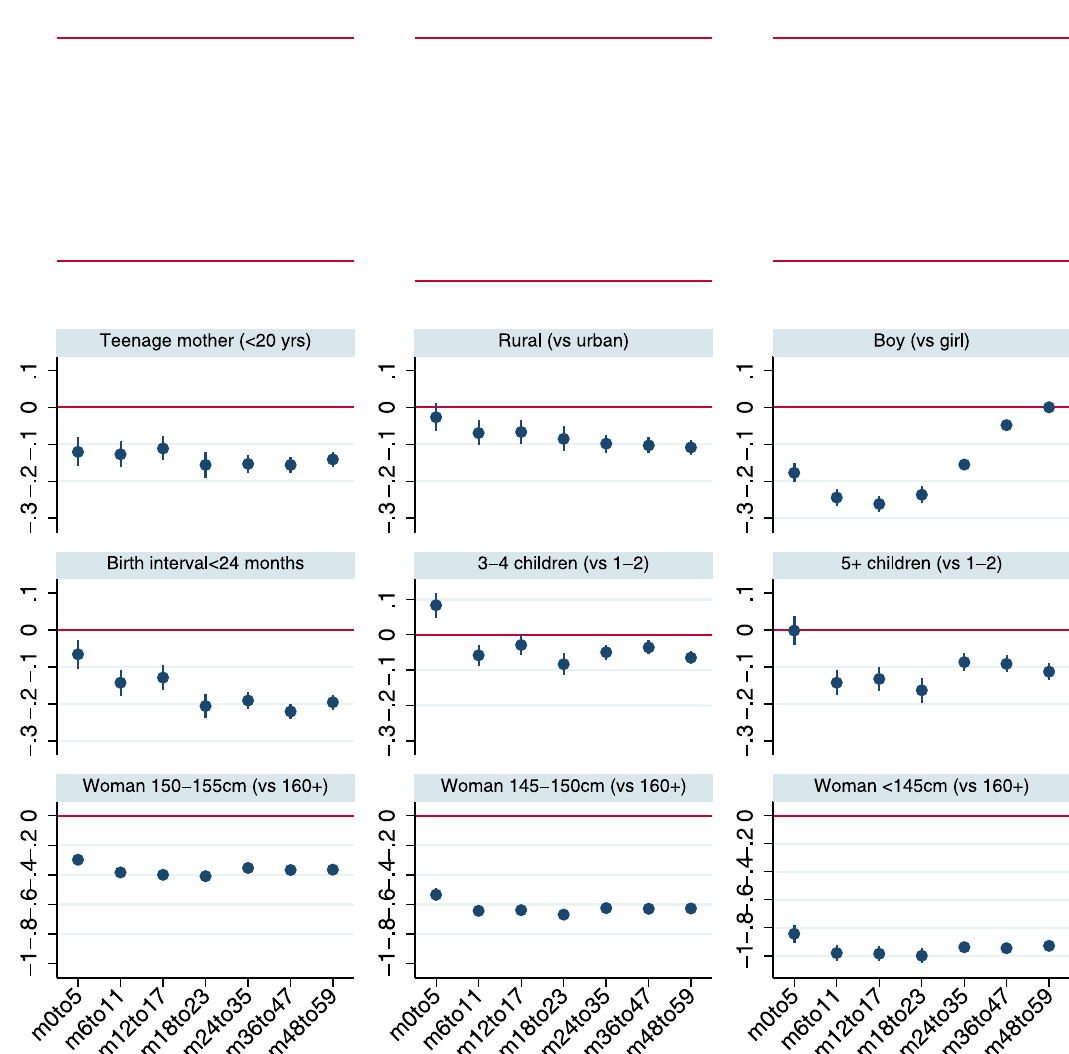
Fig 4. Least squares estimates for HAZ scores by age-restricted sub-samples: Child, maternal and household demographic indicators and maternal height. Notes: The figure reports coefficients and 95% confidence intervals based on cluster-adjusted standard errors from multivariable least squares regressions of HAZ against all the variables listed in Table 1, as well as country-year fixed effects and dummy variables for every month of child age. Samples sizes for the regressions estimated for the various age groups are 67,384 (0–5 months; m0to5 ),75,965 (6–11 months; m6to11 ),76,711 (12–17 months; m12to17 ), 68,694 (18–23 months; m18to23 ), 129,174 (24–35 months; m24-35 ),138,342 (36–47 months; m36to47 ),132,242 (48–59 months; m48to59 ).